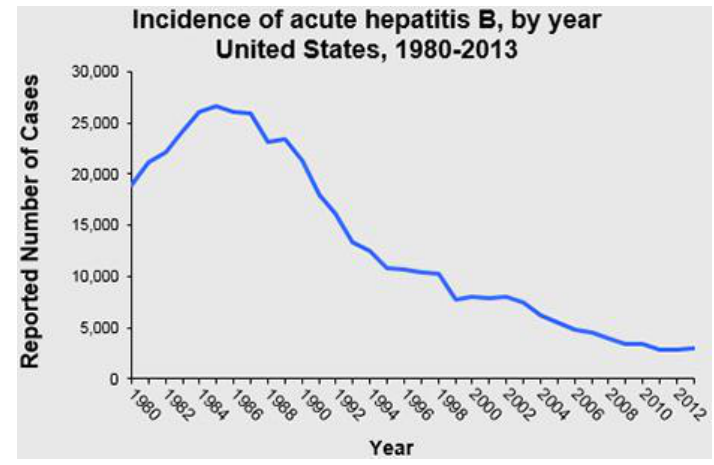
Figure 3. Reported acute hepatitis B incidence, United States, 1980-2013 [1]. Figure is used with permission from the publisher.